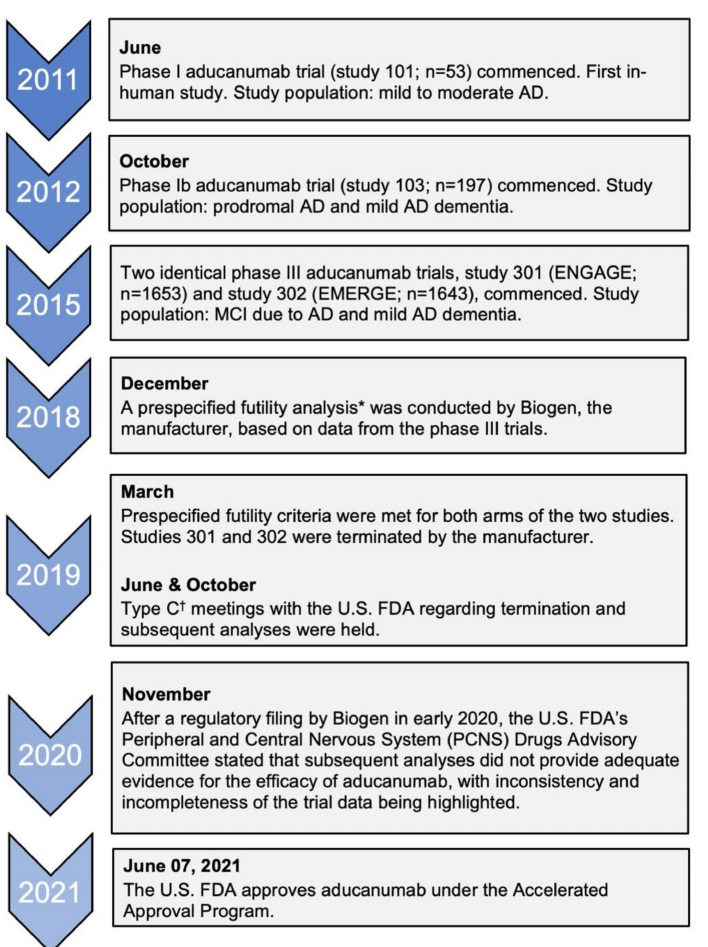
Figure 2. Timeline of clinical trials of aducanumab and key regulatory decisions. AD, Alzheimer’s disease; MCI, mild cognitive impairment. * This was defined as the conditional power being less than 20% for both dose arms of the trials to meet the primary endpoint [40]. † Type C meetings are those that do not fall into type A meetings (due to stalled product development) or type B meetings (for example, after a trial’s end-of-phase)